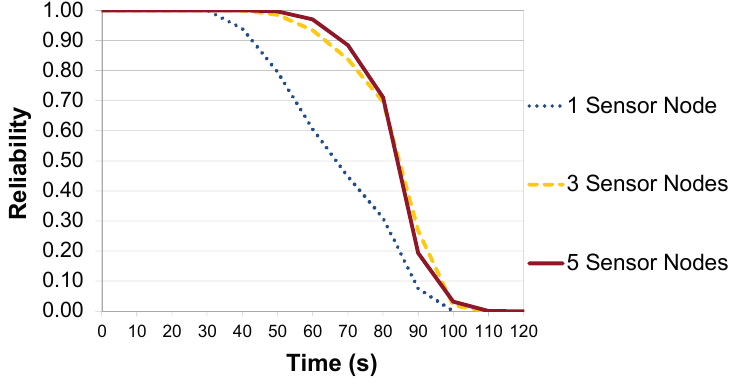
Figure 20. Reliability of the region considering different number of